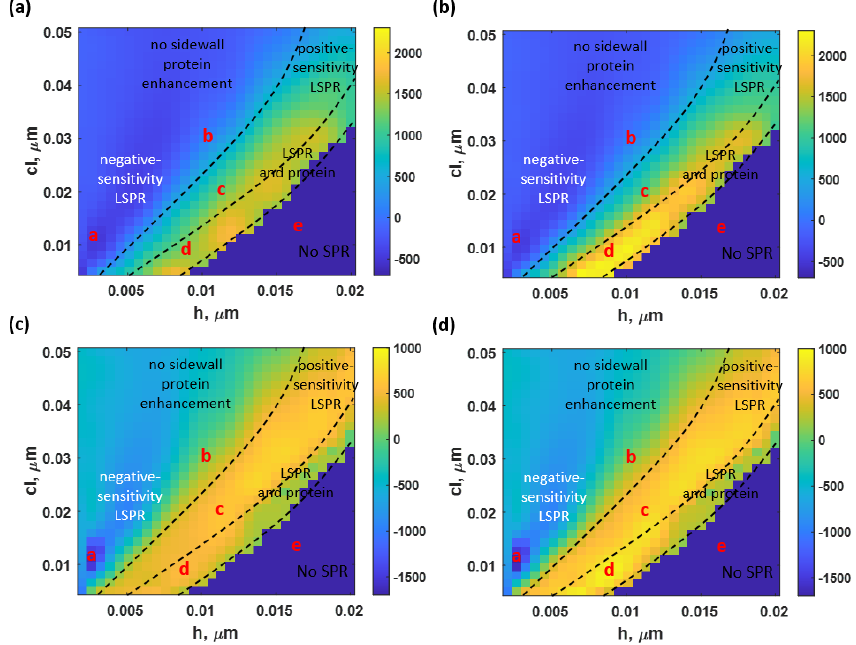
Figure 12. ( a ) the FoM 1 of the BSA without the sidewall, ( b ) BSA with the sidewall model; ( c ) FoM 2 for SPR detection [55] obtained from the BSA without the sidewall, and ( d ) BSA with the sidewall model.